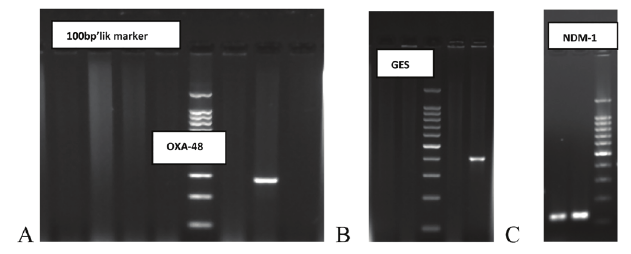
Moreover, the strains that form the A1, A2, C1, D, F, H3, L1, N, O1, O2, P1, P2 and R clusters among these clusters were 100% similar. The largest cluster was formed by the L cluster with four sub-members (L1- 100%, L1-L2 96.8%, L2-L3 Figure 1 - Gel image showing the band profile of the 281 bp OXA- 48 gene, 399 bp GES gene, 129 bp NDM-1 gene.